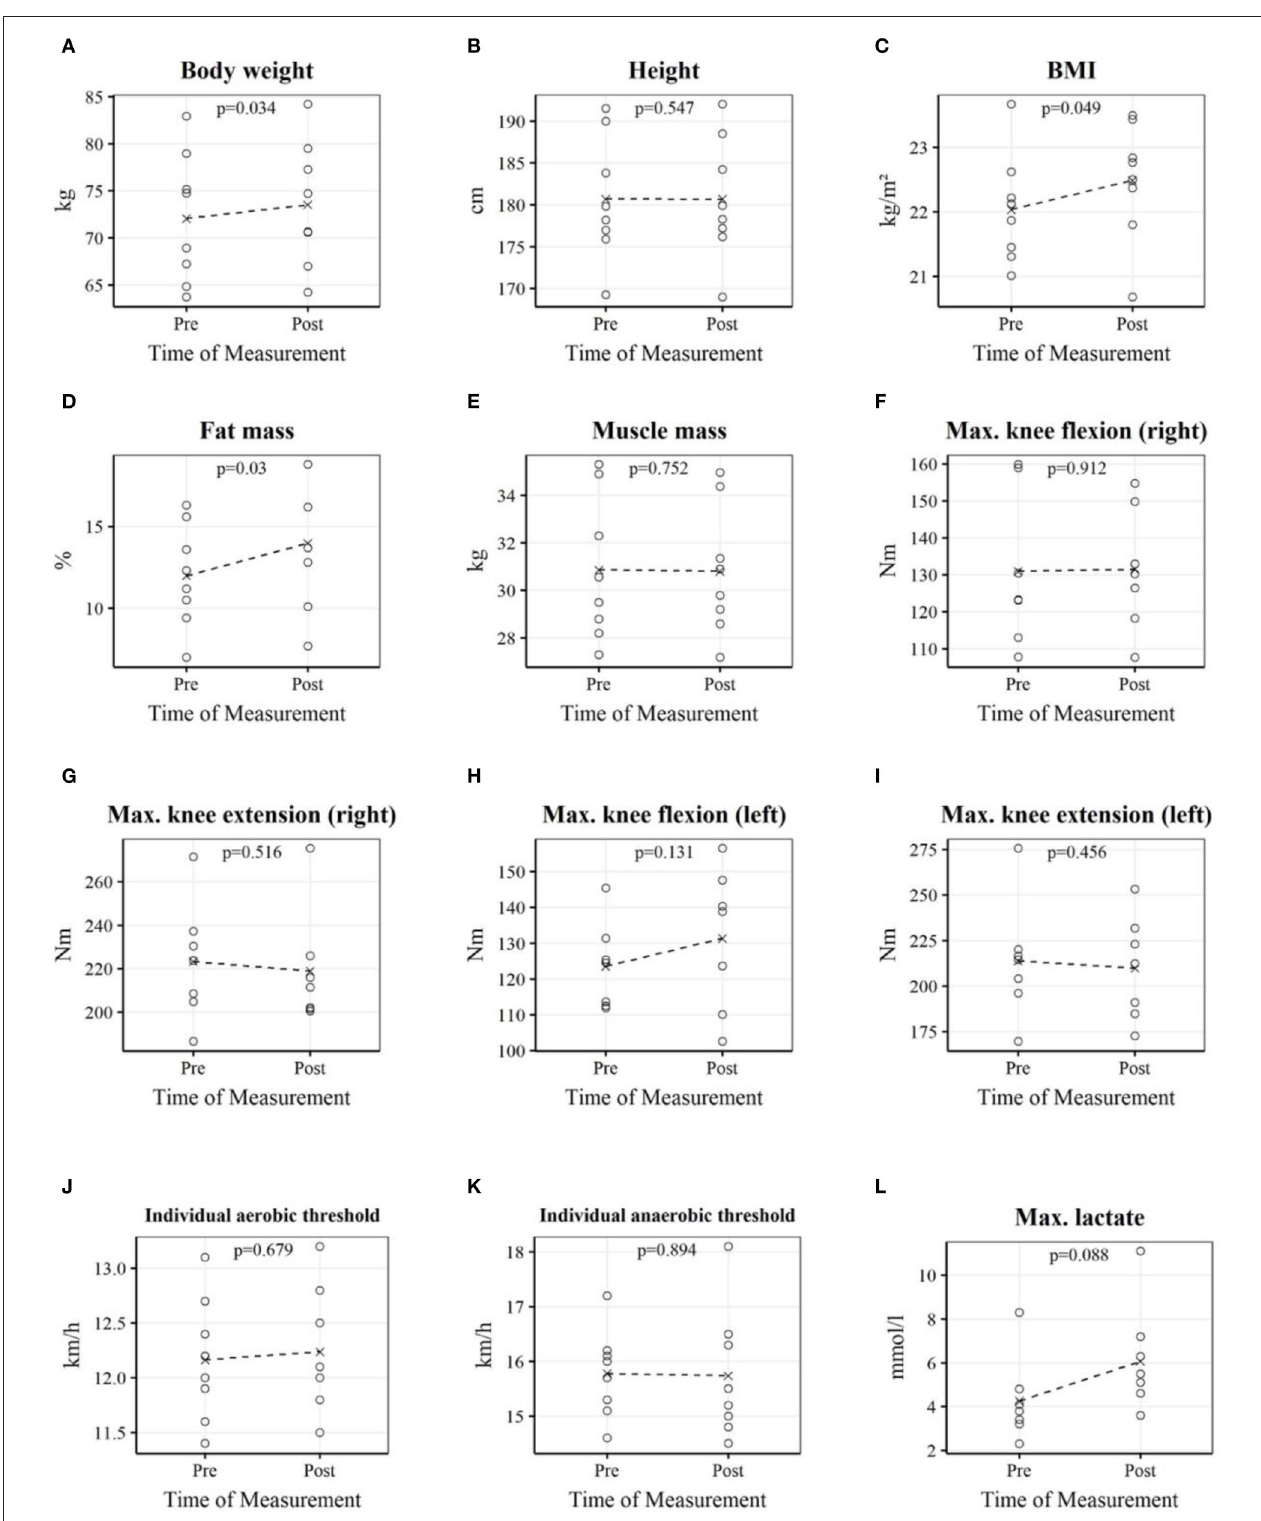
FIGURE 1 | Each plot depicts professional youth soccer players’ individual measurements as well as the mean before and after the home training period. Body weight (A) ; Height (B) ; BMI (C) ; Fat mass (D) ; Muscle mass (E) ; Max. knee flexion (right) (F) ; Max. knee extension (right) (G) ; Max. knee flexion (left) (H) ; Max. knee extension (left) (I) ; Individual aerobic threshold (J) ; Individual anaerobic threshold (K) ; Max. lactate (L) .